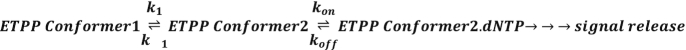
Conformational selection mechanism for dNTP binding to the enzyme-template-primer-probe complex (ETPP).